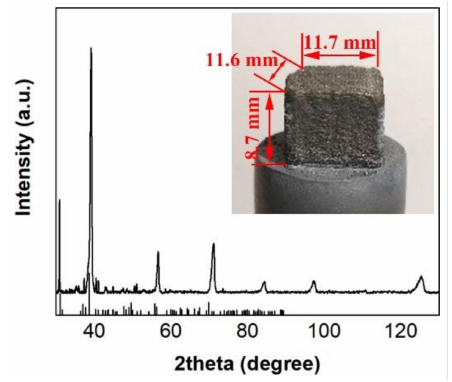
Figure 3. The X-ray diffraction (XRD) curve of the NbMoTa–Al 2 O 3 multilayer composite structure